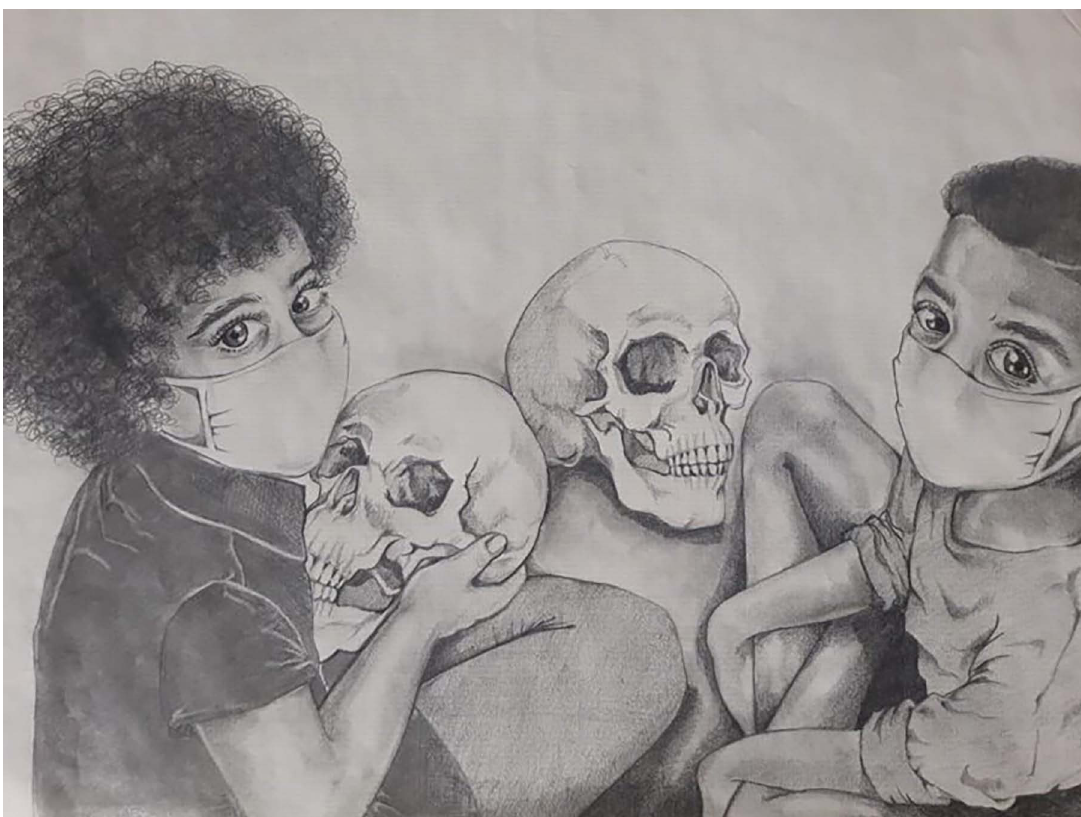
Figure 2. ‘Untitled’ by Lungile